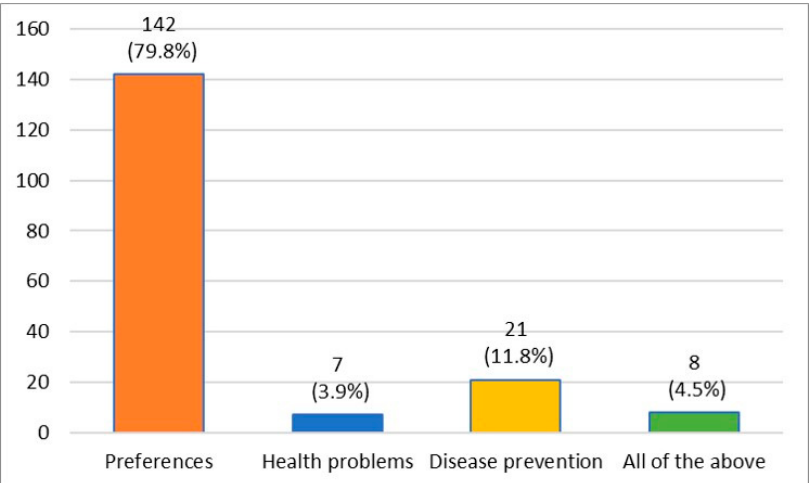
Figure 3. Distribution of the answers given by children regarding food selection.